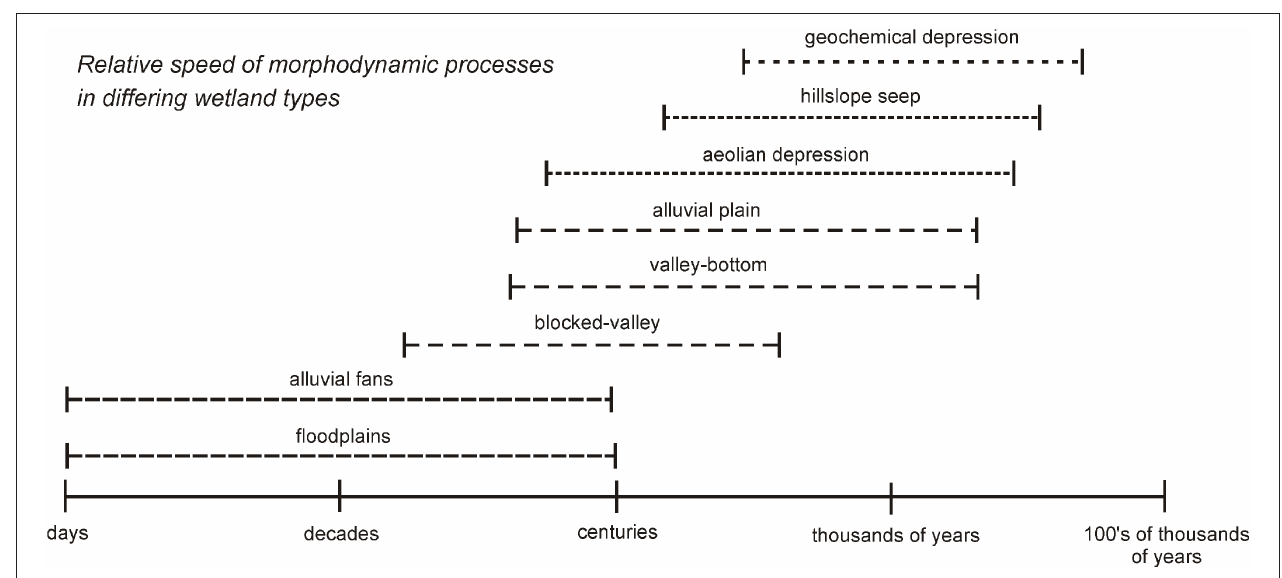
FIGURE 10 | A comparison of relative speed of typical morphodynamic processes in different wetland